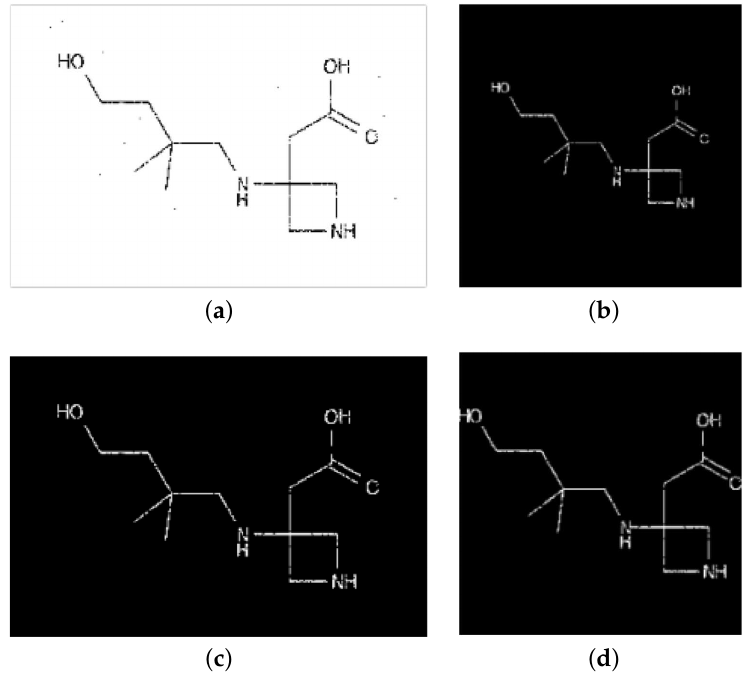
Figure 7. Comparison of original image to the image after pre-processing. ( a ) Original image. ( b ) Denoising and padding reshaping. ( c ) After denoising. ( d ) Denoising and padding reshaping, smart